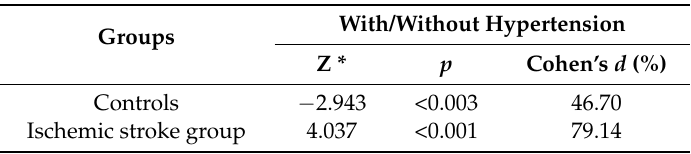
* Mann Whitney U test.